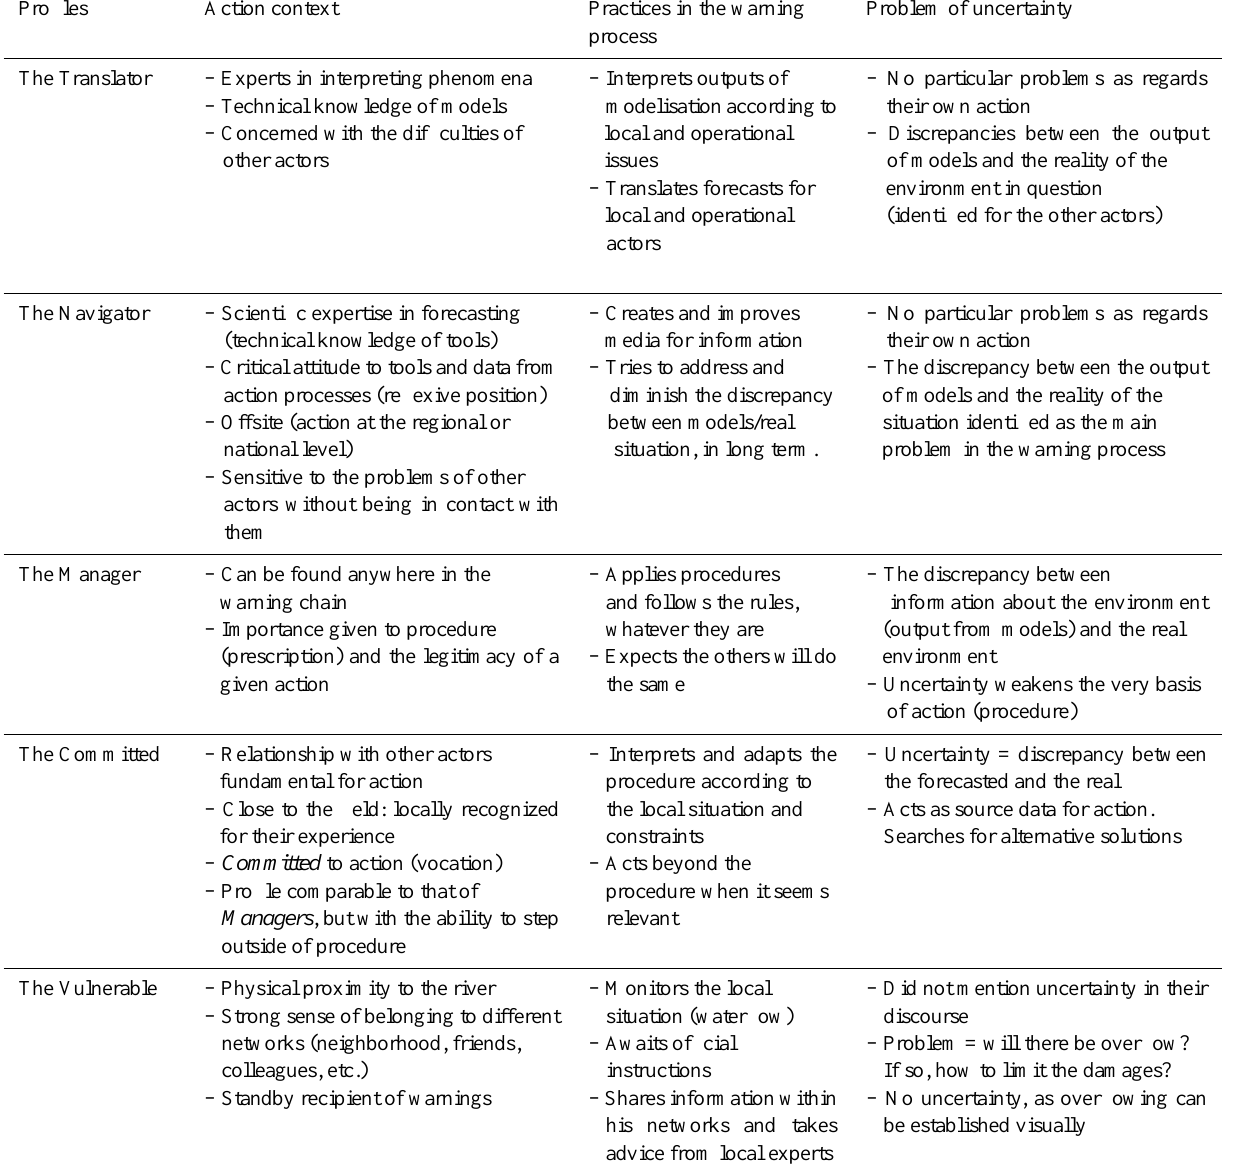
Table 1. Synthesis of the relationships between actor profiles, action context and